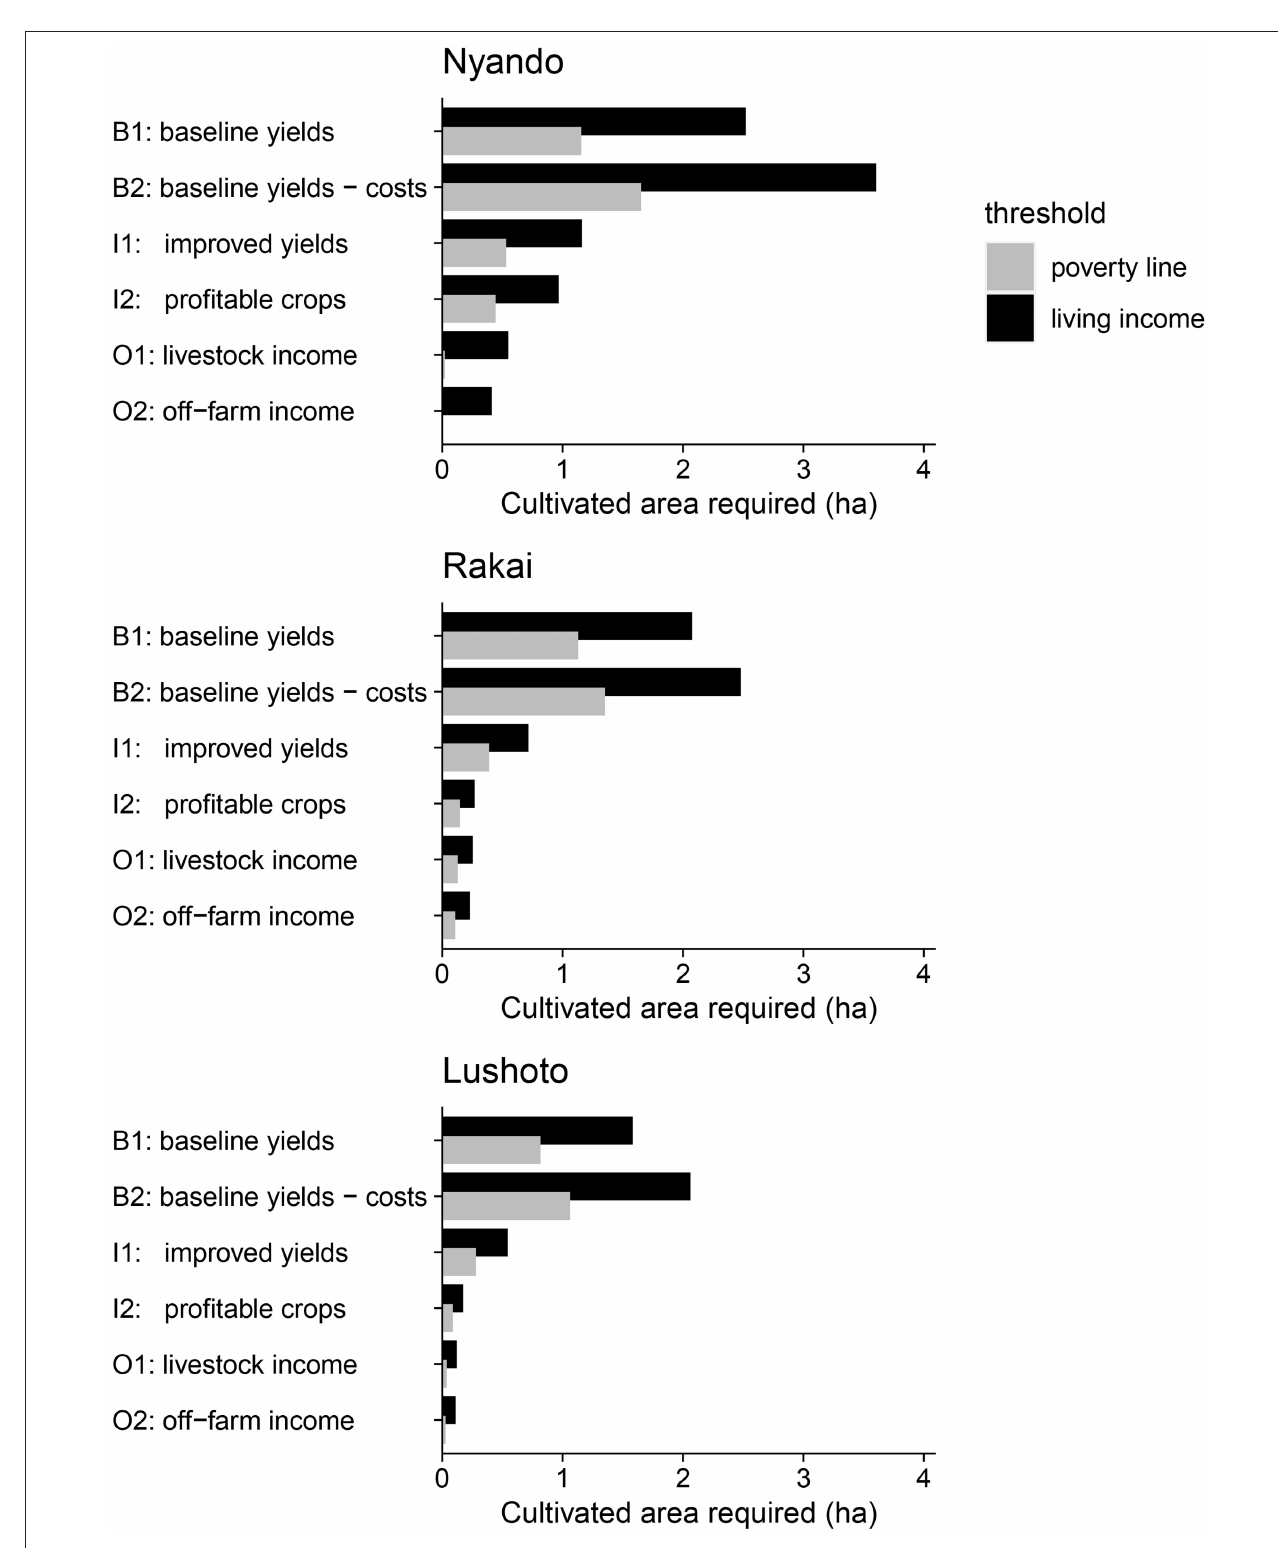
FIGURE 5 | The cultivated area required to reach the poverty line or obtain a living income (viable farm size) for a household of median size for six scenarios. All scenarios are incremental, meaning that each scenario builds on all improvements and assumptions of the previous scenario.